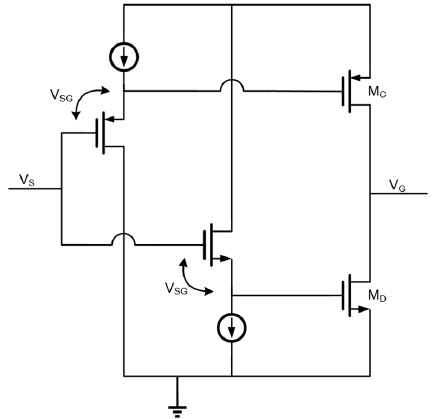
Figure 4. Circuit diagram of push–pull